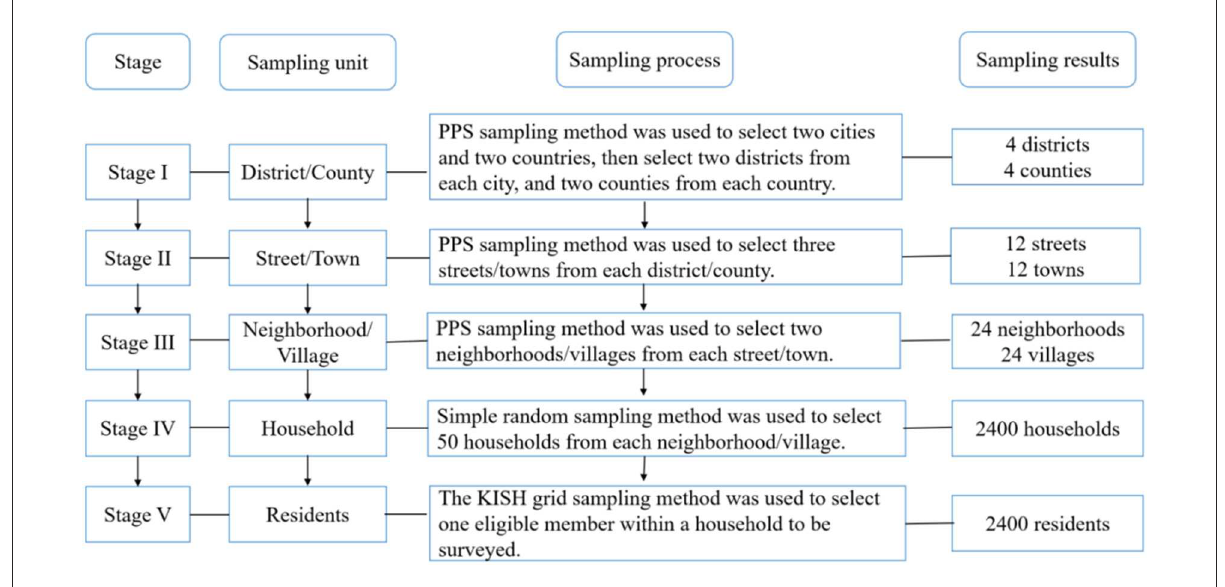
FIGURE1 The five-stage probability proportionate to size sampling process.